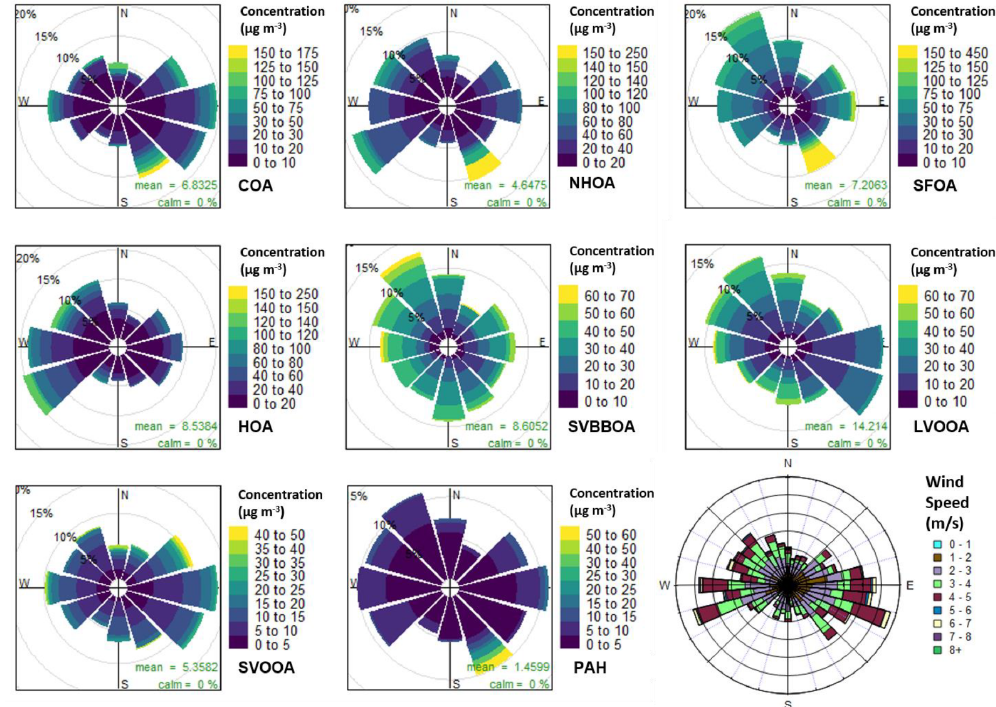
Figure 9. Pollution roses for each factor and uncalibrated PAH concentrations along with a wind rose. The pollution roses show 30 ◦ wind vectors, and their size is proportional to the percentage contribution to the mean concentration. The vectors are divided into concentration bins based on the colour scale in the